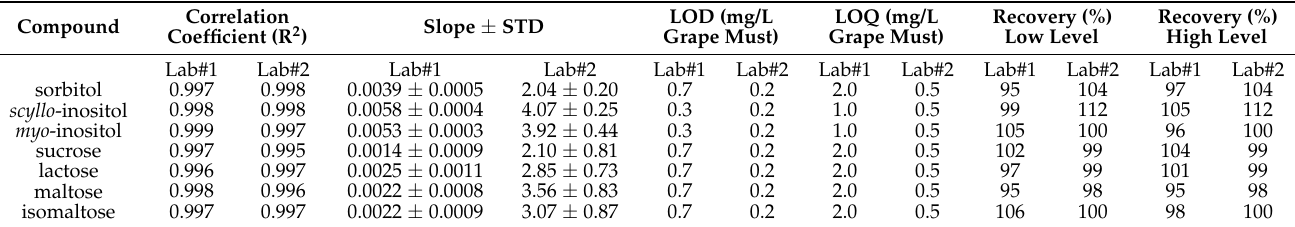
Table 1. Validation parameters: correlation coefficient (R 2 ), slope, LOD, LOQ, and recovery.